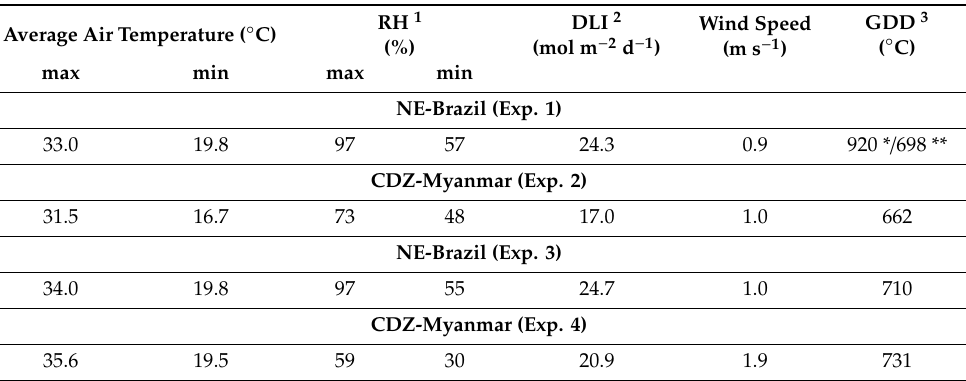
Table 4. Main climatic features during the